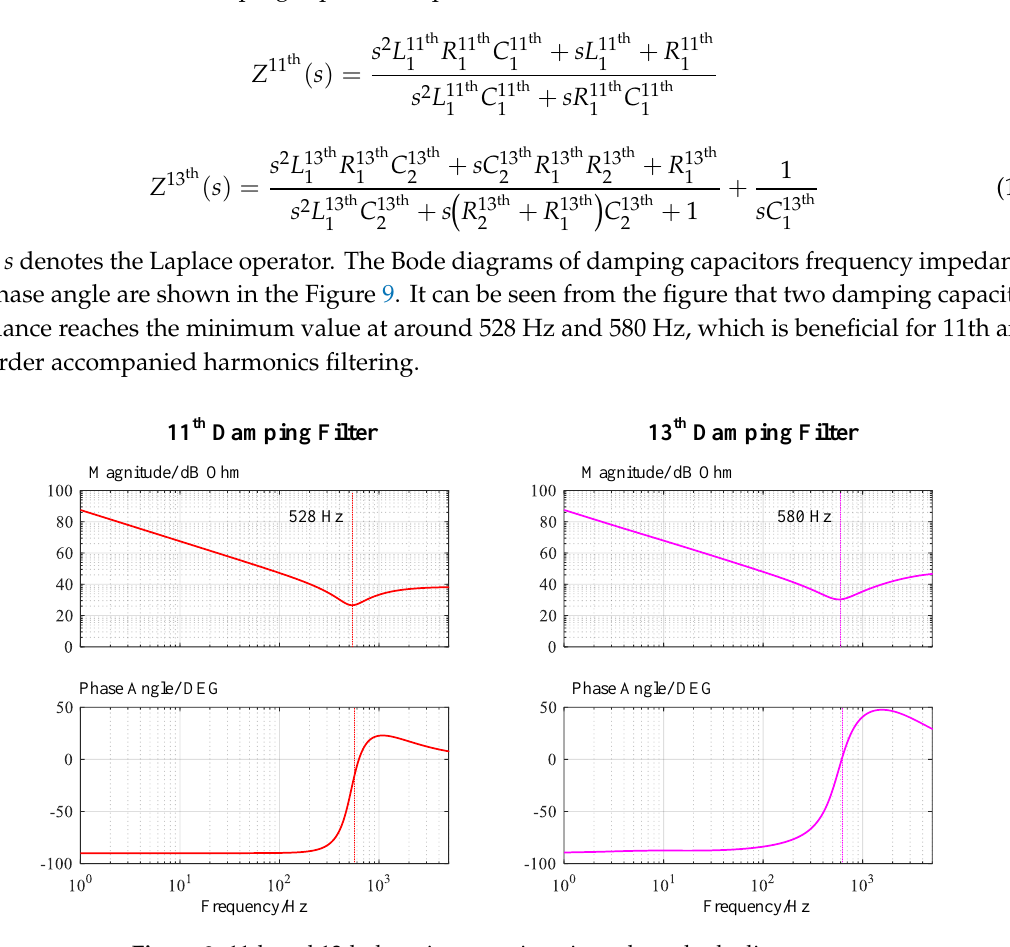
Figure 9. 11th and 13th damping capacitors impedance bode diagrams.